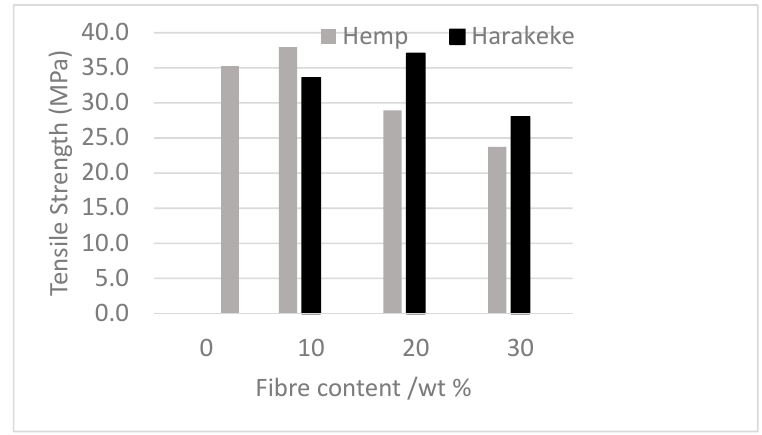
Figure 9. Tensile strength results of PLA, 10, 20, and 30 wt % hemp and harakeke printed samples.